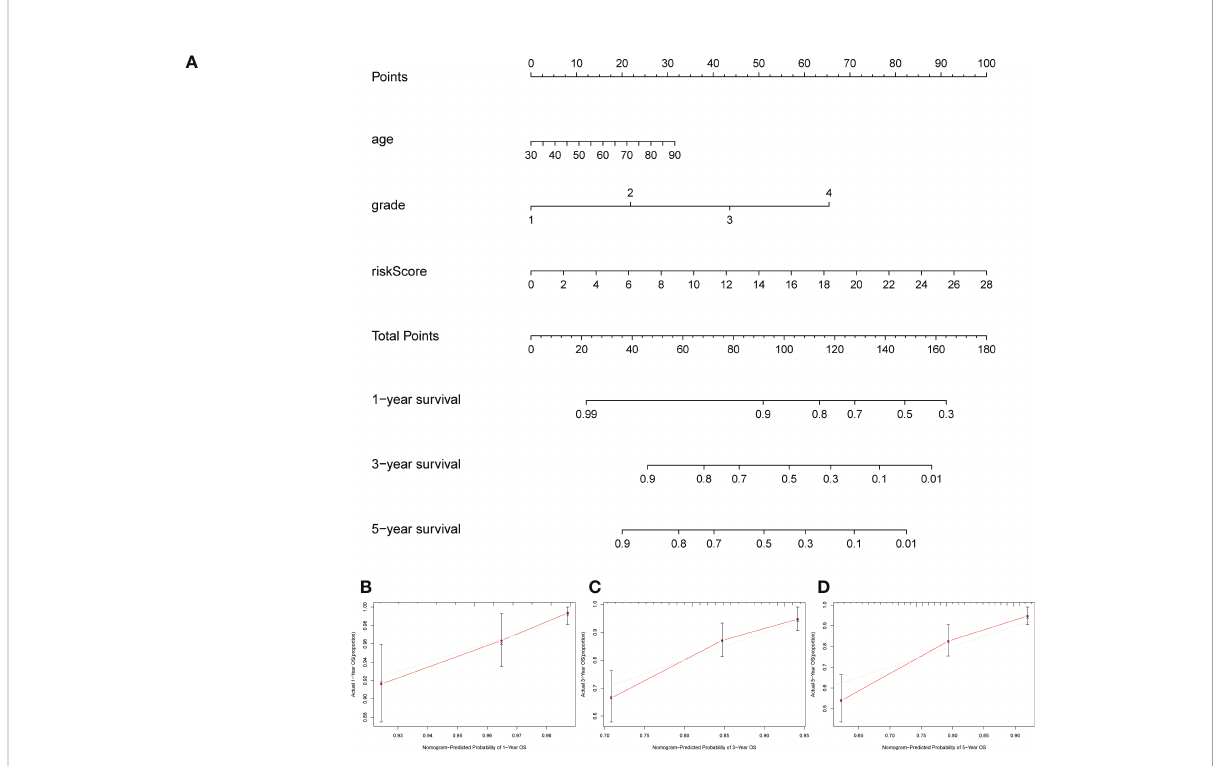
FIGURE 4 Creation and veri fi cation of the nomogram. (A) A nomogram integrating age, grade and risk score to predict 1-, 3-, and 5-year OS for UCEC patients. (B – D) Calibration curves tested the agreement between actual OS rates and predicted 1-, 3-, and 5-year survival rates. OS, overall